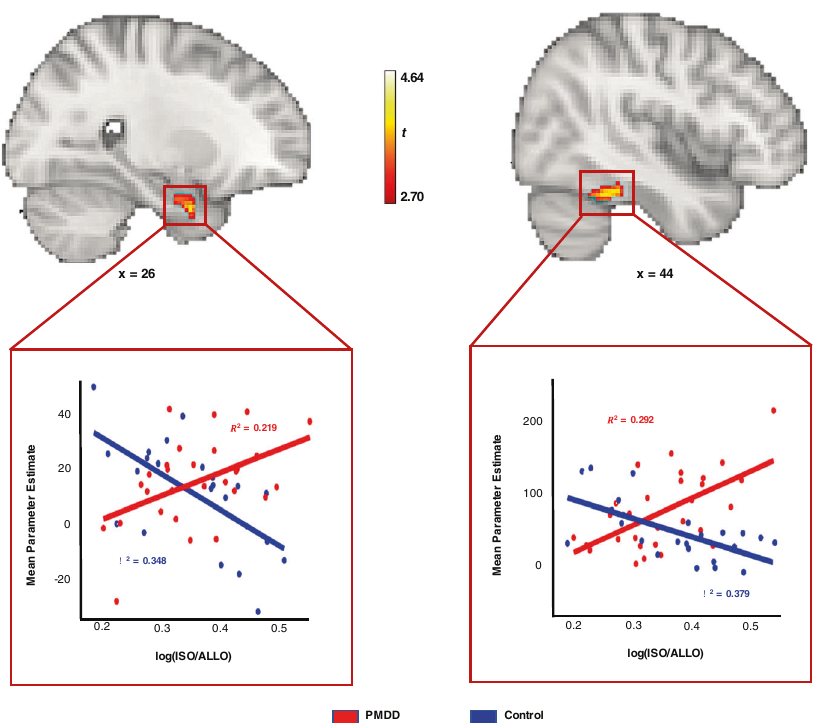
Fig. 3 Group differences in associations between emotion-induced brain activity and log(ISO/ALLO) serum levels in subjects with PMDD ( N = 29) and controls ( N = 24) during the late-luteal phase of the menstrual cycle ( p FWE < 0.10, TFCE). Upper: Brain slices depicting clusters in which the interaction between brain activity during task [Faces>Shapes contrast] and log(ISO/ALLO) serum levels differed between groups ( p FWE < 0.10, TFCE). The cluster in the parahippocampal gyrus/amygdala region was signi fi cant at the p FWE < 0.05 level, while the cluster in the fusiform gyrus was marginally signi fi cant with p FWE = 0.06. The analysis was conducted voxel-wise within a mask combining brain regions showing increased task-related activation for both PMDD and controls. Lower: Corresponding scatter plots illustrating the relationships between mean parameter estimates extracted from signi fi cant clusters and serum ISO/ALLO levels. Simple regression lines were added for visualization. Subjects with PMDD exhibited positive associations between log(ISO/ALLO) levels and brain activity in the right parahippocampal gyrus/amygdala and right fusiform gyrus. Control subjects, on the other hand, showed signi fi cant negative associations between log(ISO/ALLO) and brain activity in both clusters. ALLO Allopregnanolone, FWE Family Wise Error correction, ISO isoallopregnanolone, PMDD Premenstrual Dysphoric Disorder, TFCE Threshold-Free Cluster The present study found a positive association between anxiety symptoms and brain responses to emotional faces in the cerebellar lobules V-VI and anterior vermis in subjects with PMDD. These areas are part of the “ emotional cerebellum ” and are hypothesized to be involved in numerous aspects of emotion processing, including the perception, recognition, and evaluation of emotion, as well as its integration into behavior [63]. Structural, neurochemical and functional abnormalities have been observed in the cerebellum of patients with other psychiatric disorders, including bipolar and unipolar depression, which share aspects of PMDD symptomatology [63]. In PMDD, fMRI and positron emission tomography (PET) studies have observed greater activity in the emotional cerebellum relative to controls [64], and one study reported that increases in cerebellar activity from the follicular to the luteal phase was correlated to worsening of core mood symptoms [65]. In sum, there is some evidence to suggest that dysfunction in the emotional cerebellum plays a part in the neuro- pathophysiology of PMDD. This long-overlooked part of the brain warrants more attention in future research. The present study has a number of strengths, amongst which are 1) its relatively large sample size in the context of neuroimaging studies of PMDD, 2) con fi rmation of menstrual cycle phase through cycle mapping and hormonal assessment, 3) minimization of order effects through the counterbalancing of menstrual cycle phase for the fi rst scanning session, 4) usage of both ROI and whole-brain